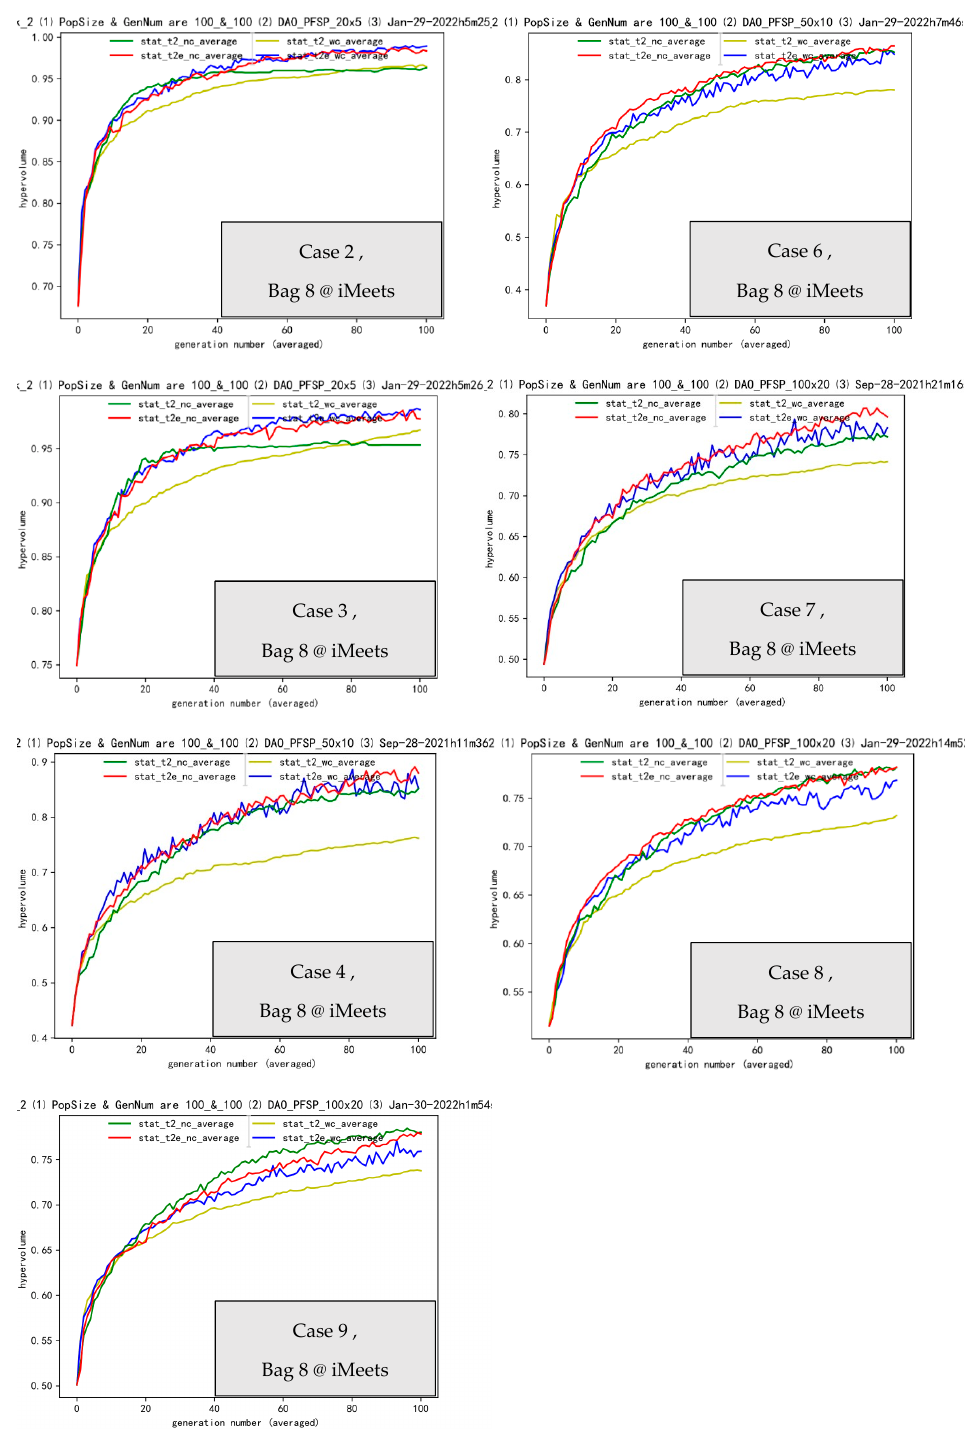
Figure 10. Cases 1, 2, ..., 9 for Bag 8 are presented above. Bag 8 is connected with Bag 6, but still differs from it. Notes: (1) “stat” means statistics of hypervolume, which is focused on